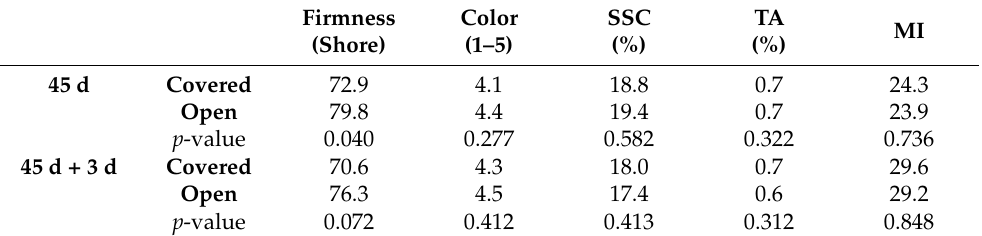
Table 4. Mean values for the physicochemical quality characteristics of ‘Santina’ sweet cherries grown under high tunnels (covered) or in the open after 45 days of cold storage (45 d) and 3 days of shelf life at 20 ◦ C (45 d + 3 d) in the Central Valley of Chile. Plot 1, growing season